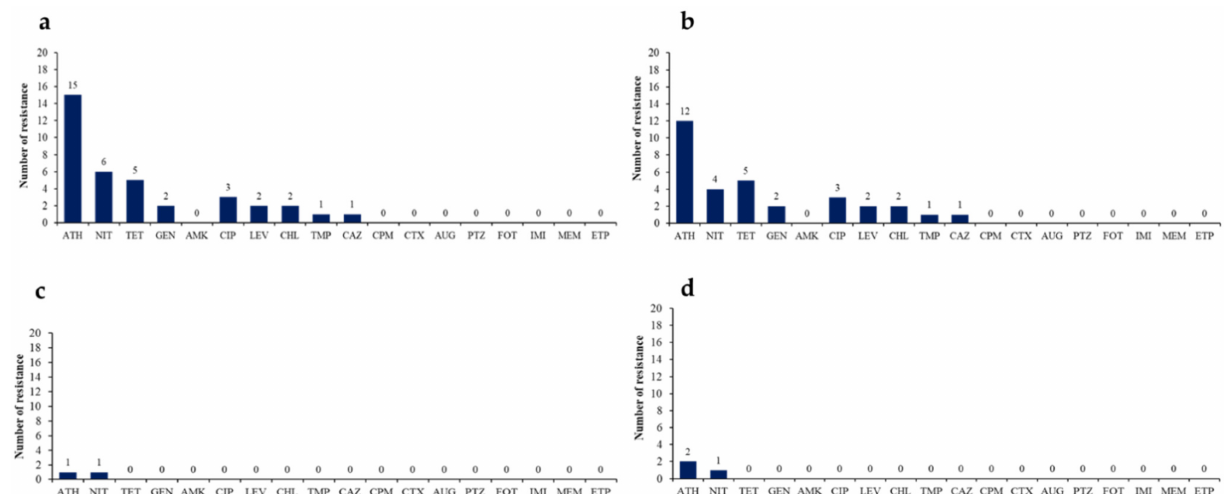
Figure 1. Antimicrobial resistance of KpnC isolates from slaughtered pigs: ( a ) Number of 19 mcr -positive KpnC isolates; ( b ) K. pneumoniae ; ( c ) K. variicola ; and ( d ) K. quasipneumoniae . Abbreviations: gentamicin (GEN), amikacin (AMK), amox- icillin/clavulanic acid (AUG), piperacillin/tazobactam (PTZ), cefepime (CPM), cefotaxime (CTX), ciprofloxacin (CIP),